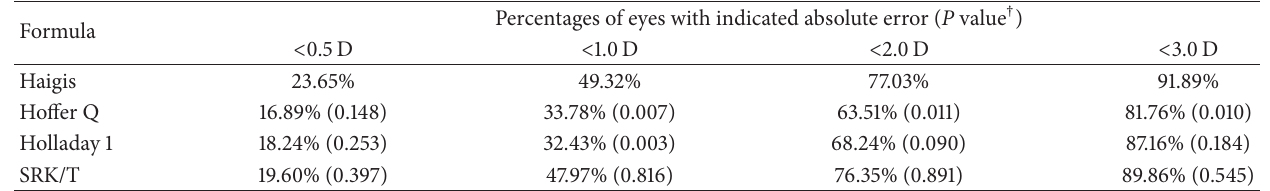
Table 3: Percentages of eyes with different absolute errors at different refractive thresholds.